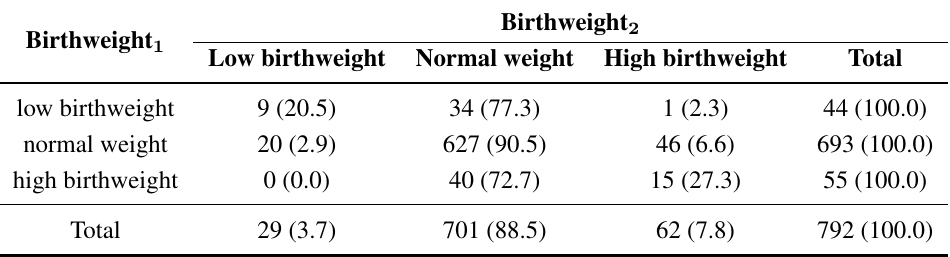
Table 7. Absolute frequencies of low, normal and high weights of first and second babies (in parentheses there are the conditional percentage values of second newborns given first newborns).